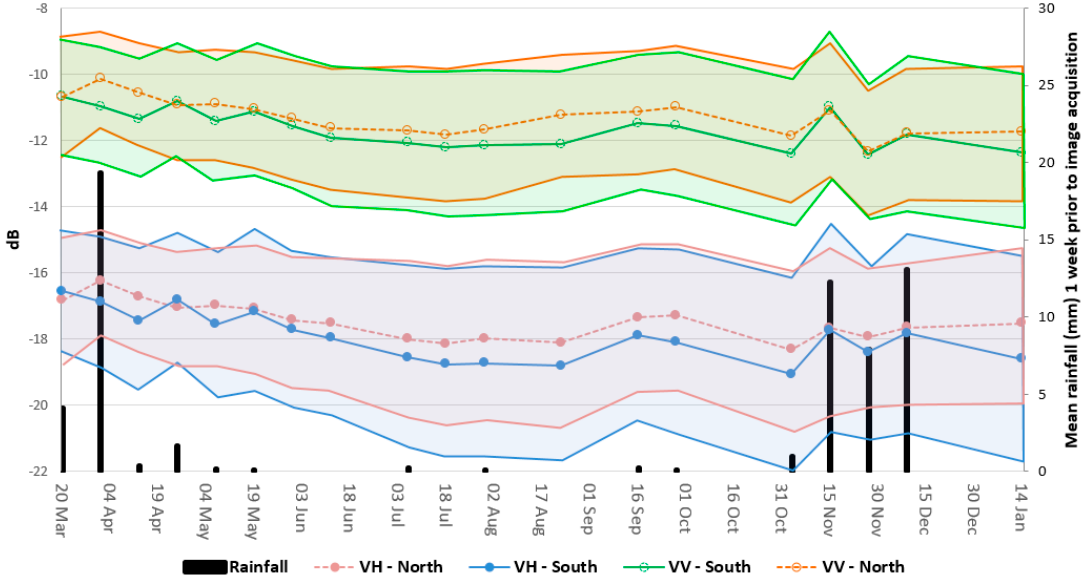
Figure 6. Mean VH and VV backscatter values for the 19 Sentinel-1A C-band images acquired from 20 March to 14 January 2016 over the Kruger National Park. The colored areas indicate plus and minus one-time standard deviation around the mean. The mean backscatter values are computed for the northern ( > 24 ◦ S) and southern ( < 24 ◦ S) sections of the park as shown in Figure 1. The mean total rainfalls for the seven days preceding each Sentinel-1 acquisition are also shown as black bars.